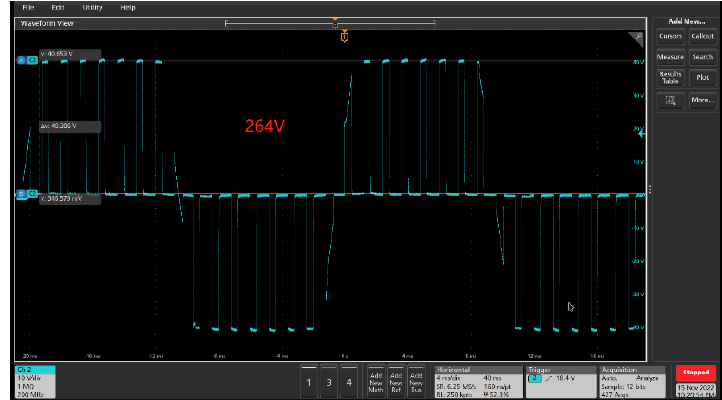
Figure 16. Characteristic current value 3 of practical test waveform.